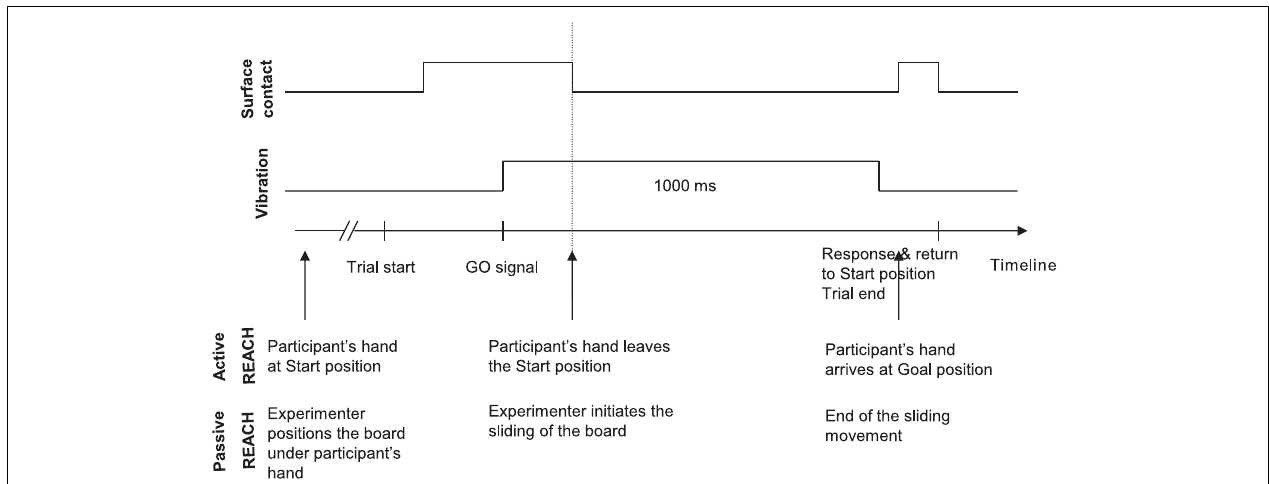
FIGURE 3 | Schematic depiction of the trial timeline for the REACH movement conditions. The vibration duration and the contact with the surface of the board are presented for the two types of movement execution modes (active and passive). The EXPLORE movement